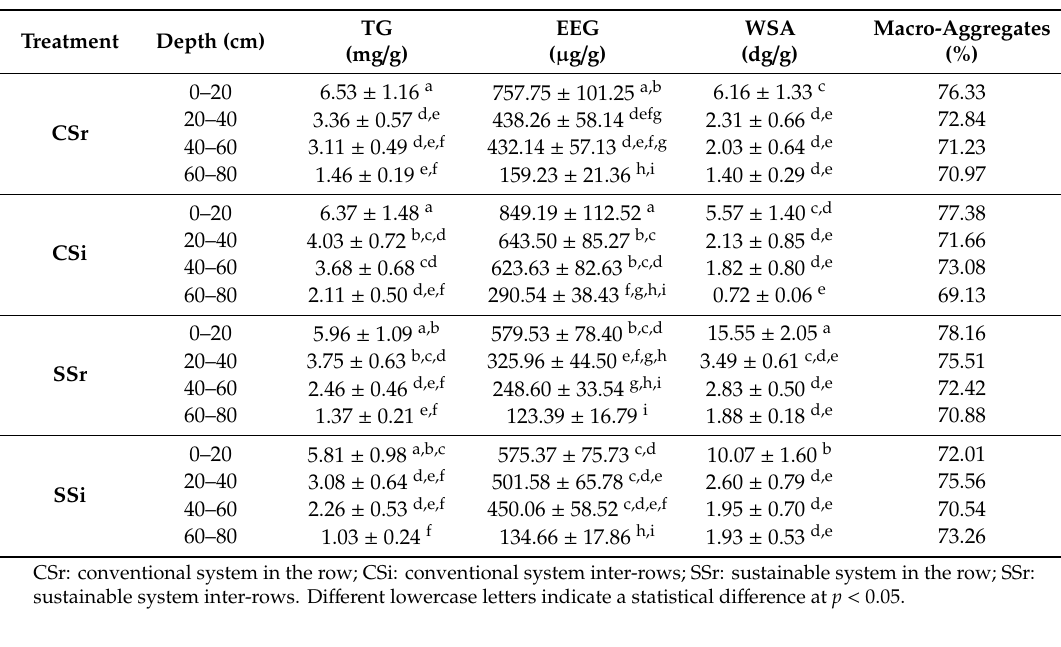
Table 3. Average water stable aggregates (WSA), total (TG), and easily extractable (EEG) glomalin concentrations measured in the two fields per position and depth.